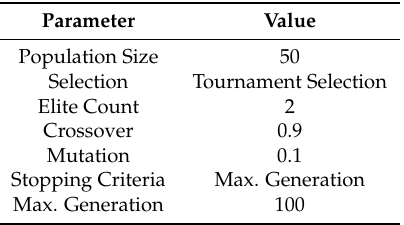
Table 2. GA parameters and